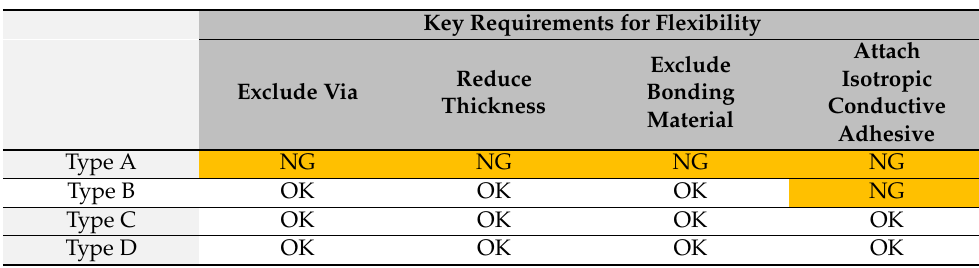
Table 2. Whether each structural type met key requirements for flexibility. In the case of Type A and Type B, the requirements for flexibility were not satisfied, as described in the yellow background of the table.